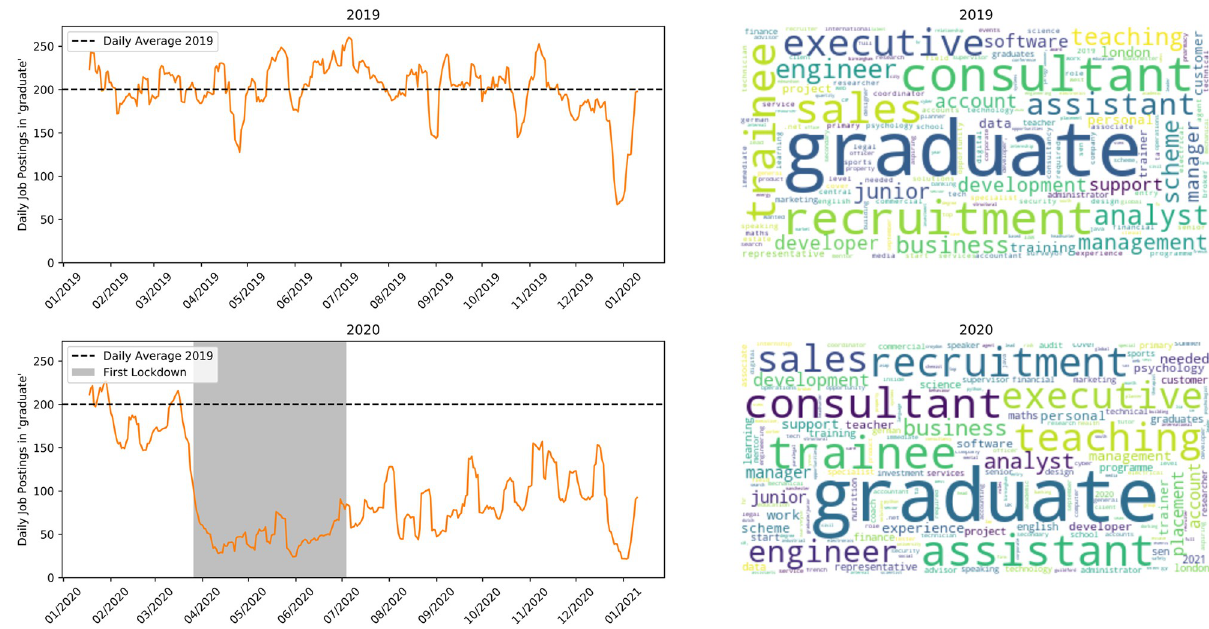
Fig 5. Jobs matching ‘graduate’. Top row is 2019, bottom is 2020.